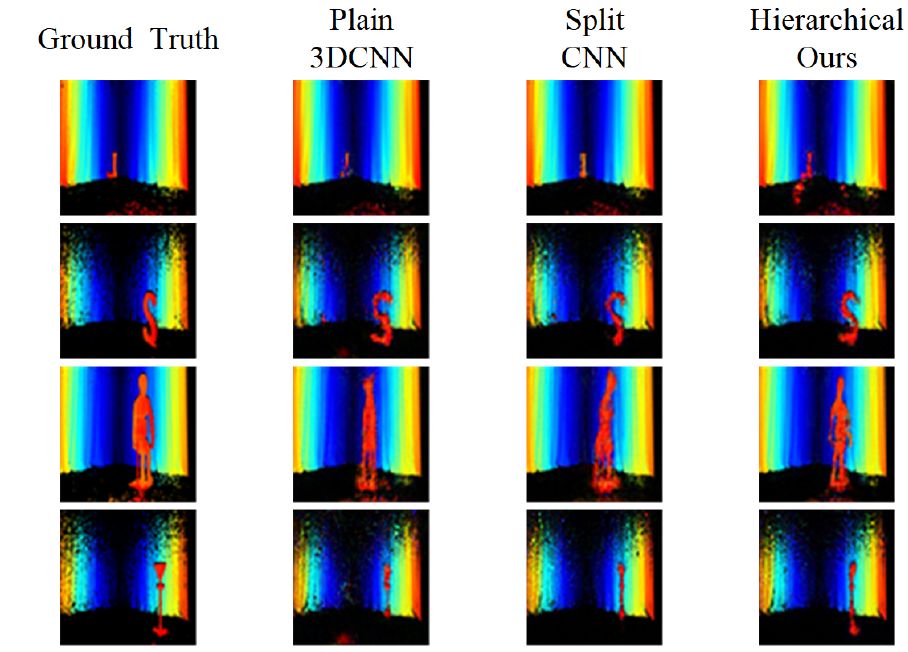
Figure 9. Comparison of image reconstruction according to encoder